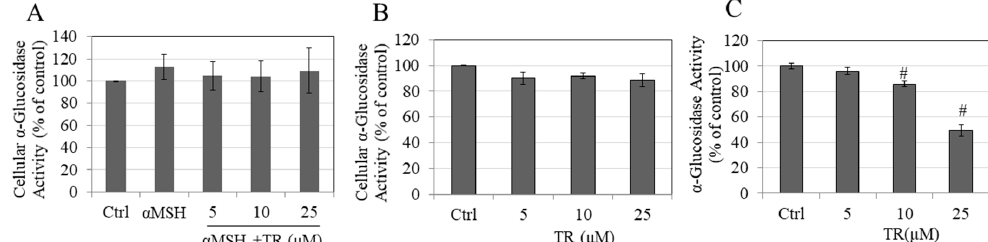
Figure 5. Intracellular α -glucosidase activity measured in B16F10 cells in ( A ) α -MSH stimulated and ( B ) Basal melanogenesis; Data are mean ± SD of at least two independent experiments; ( C ) α -glucosidase activity measured in a cell-free system; # p < 0.01 versus Ctrl, One-way ANOVA followed by Dunnett’s test; Data are mean ± SD of triplicate determinations.